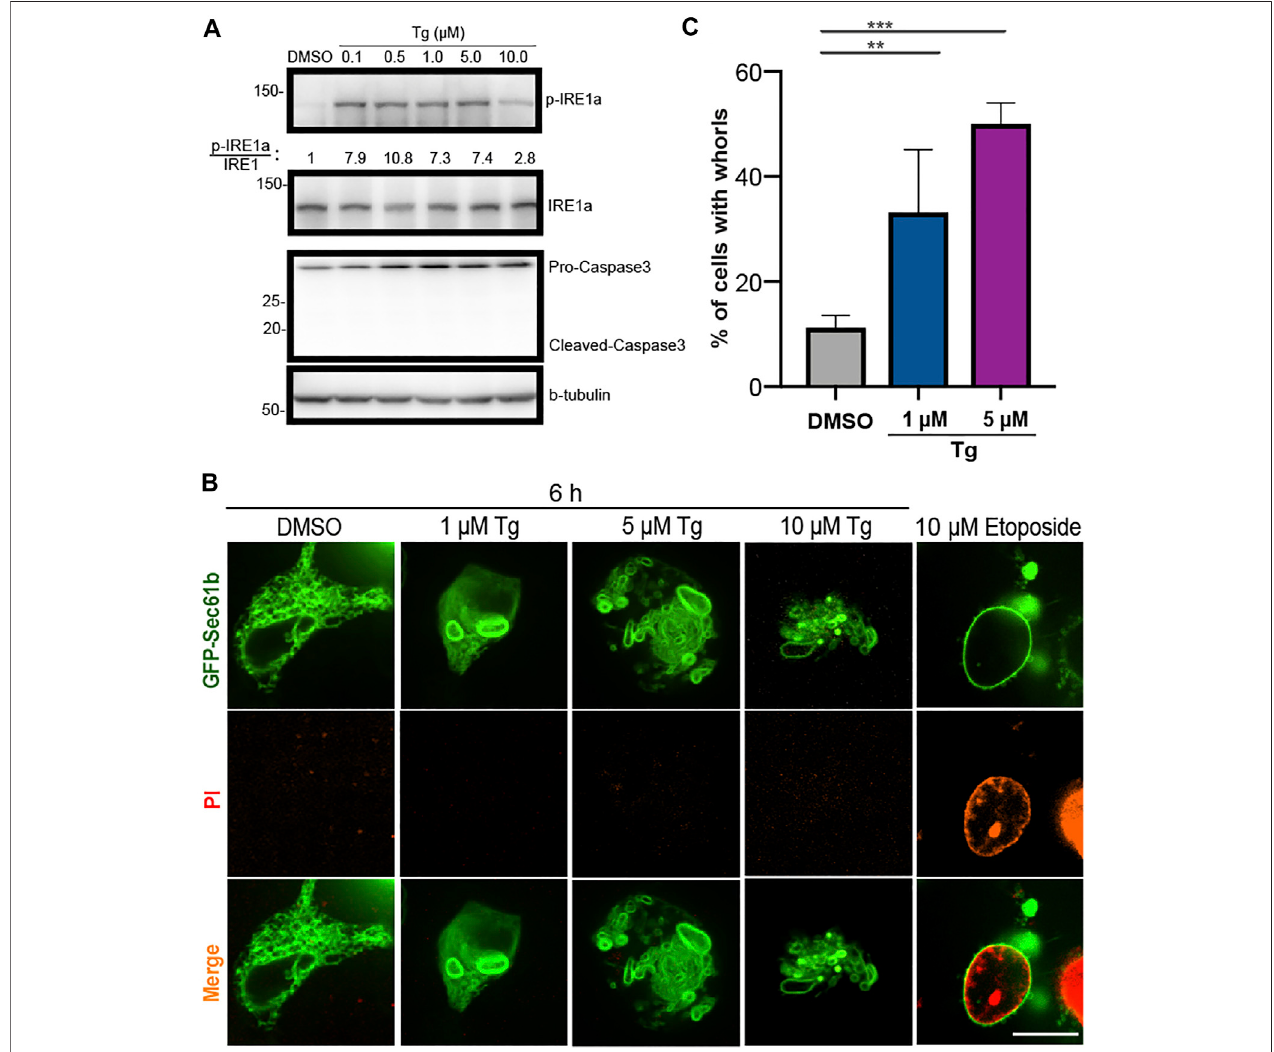
FIGURE 1 | Upregulated ER stress markers and abnormal ER shapes in HEK293T cells treated with Tg at different concentrations. (A) Immunoblot analysis of p-IRE1 α , IRE1 α , caspase3 (pro and cleaved) and β -tubulin from cell lysates after treatment of HEK293T cells with DMSO or Tg at the indicated concentrations for 6 h. The ratio of p-IRE1 α to IRE1 α is shown for each concentration. (B) Representative ER structures labeled with GFP-Sec61 β (green) in HEK293T cells treated with Tg at the indicated concentrations for 6 h. PI staining was used to detect cell apoptosis. No substantial PI staining signal was detected in Tg treated cells (second row). EtoposidetreatedcellswereusedasareferenceandapositivecontrolforPIstaining.Scalebar:10 μ m. (C) PercentageofHEK293TcellswithERwhorlsaftertreatment with DMSO or Tg at different concentrations for 6 h. Error bars indicate standard deviation (SD) calculated from three independent experiments. **: p < 0.01, ***: p <